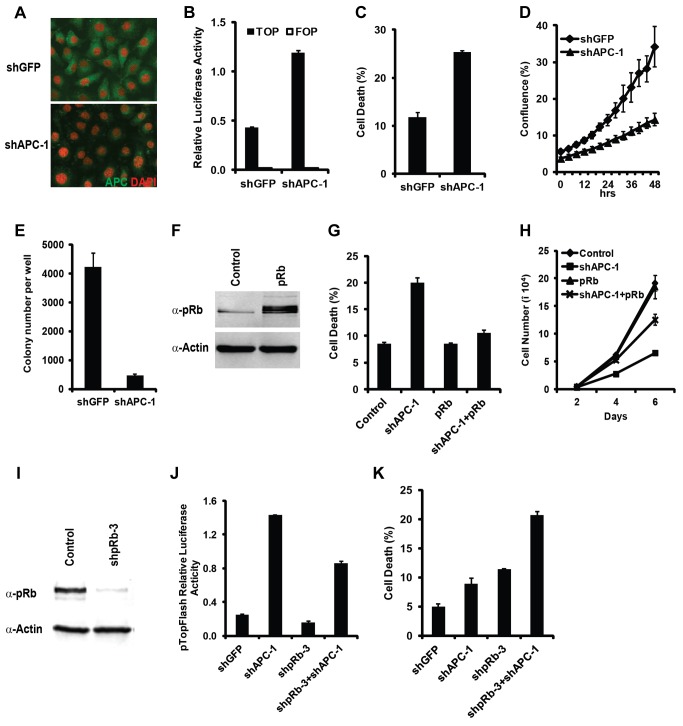
Hyperactivation of Wnt signaling and inactivation of Rb induced synergistic cell death effect in mammalian cells.In Rb mutant Du145 cells, knockdown of APC strongly reduced the level of APC protein detected by antibody staining (A) and increased the Wnt signaling reporter activity detected with the TOP-FOP luciferase assay (B). Knockdown of APC enhanced cell death (C), decreased the viable cell numbers (D), and inhibited the colony growth in soft agar (E). Overexpression of Rb restored WT pRb in Du145 cells (F), decreased the APC knockdown-induced cell death (G), and partially rescued the cell proliferation defect (H). (I–K) In HCT116 cells, knockdown Rb using shRb-3 significantly reduced the endogenous pRb level (I). (J and K) The effect of knockdown Rb and APC on Wnt pathway activity detected with the TOP-FOP luciferase assay (J) and on cell death detected by Annexin V staining (K).